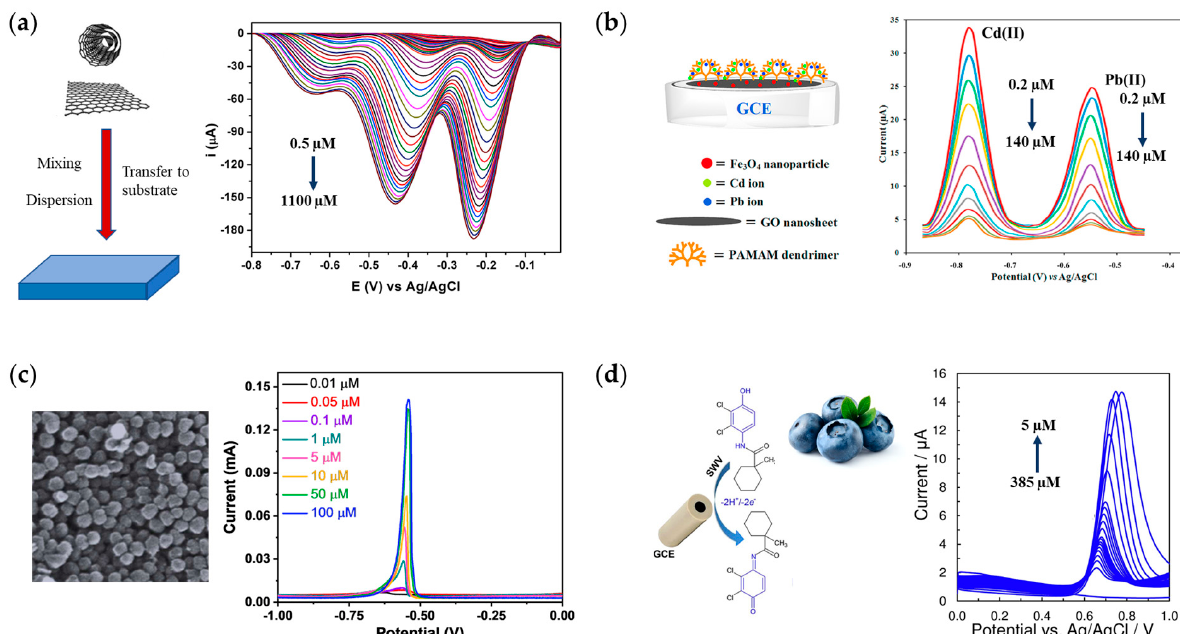
Figure 13. ( a ) The nanocomposite of reduced graphene oxide/MWCNTs for high sensitivity of trinitrotoluene) [124]. ( b ) Functionalized magnetic graphene oxide for the determination of Pb and Cd [125]. ( c ) Carbon nanoparticles modified with plasma towards ultrasensitivity of heavy metal ions [126]. ( d ) Fungicide fenhexamid in berries and wine grapes determination using carbon − based electrode